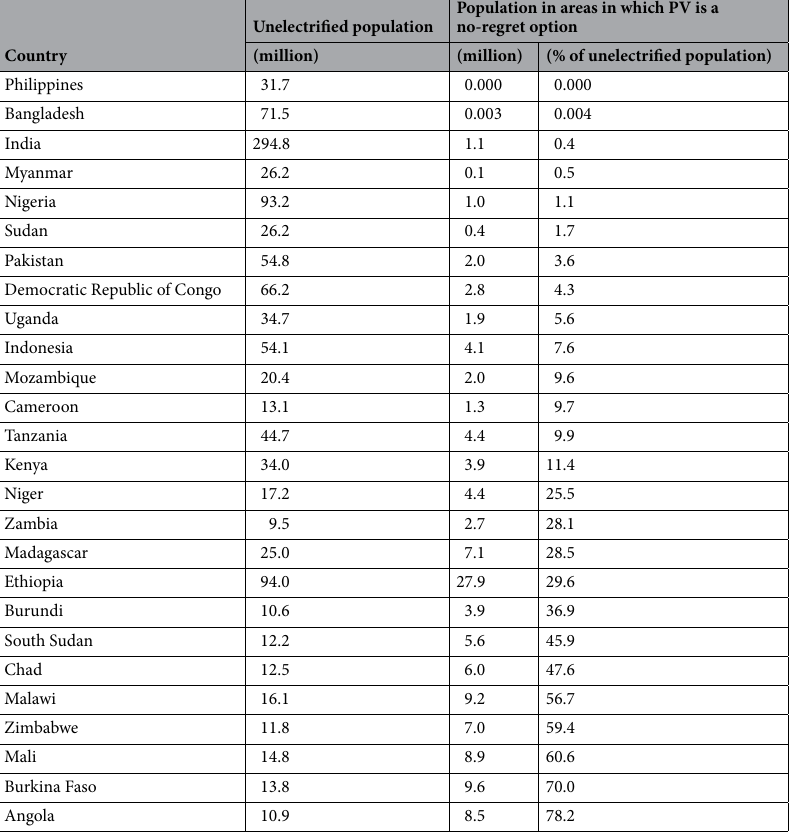
Table 4. Decentralized PV as a no-regrets investment option, by country. Source: Authors’ compilation based on the